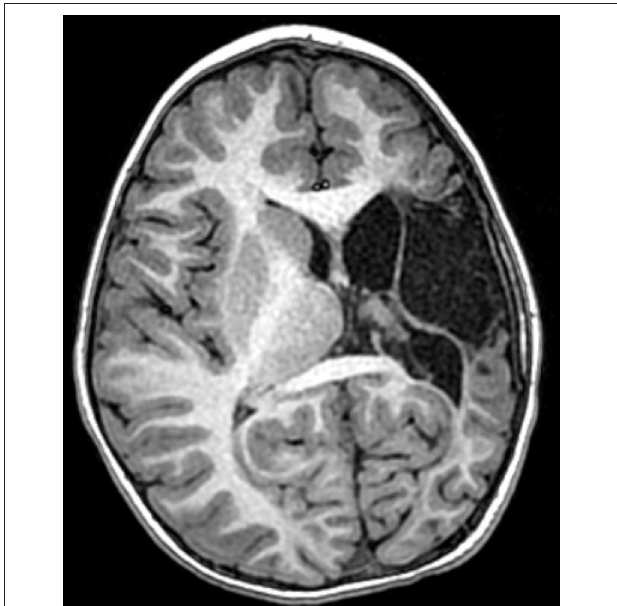
FIGURE 1 | Patient #x. Axial T1-weighted MRI obtained at age 5 years, demonstrating a left middle cerebral artery distribution infarct and a disproportionately small left cerebral hemisphere.